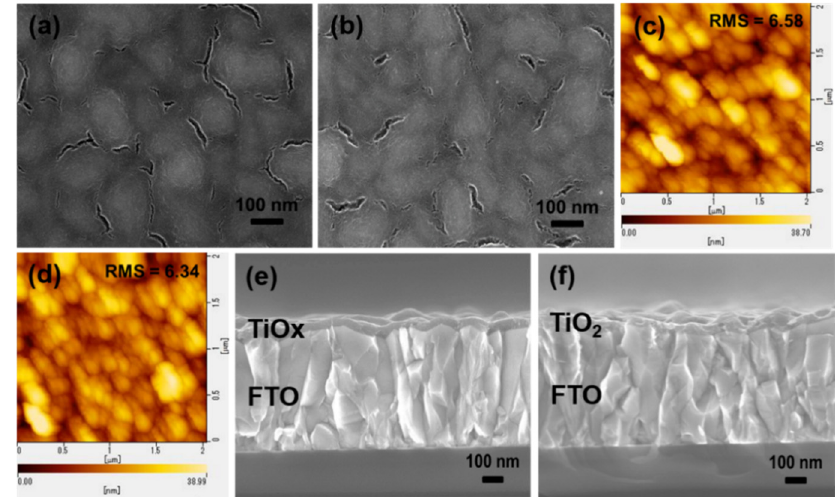
Figure 2. SEM images of the ( a ) TiO x film and ( b ) TiO 2 film; atomic force microscopy (AFM) images of the ( c ) TiO x film and ( d ) TiO 2 film; and cross-section SEM images of the ( e ) TiO x film and ( f ) TiO 2 film.